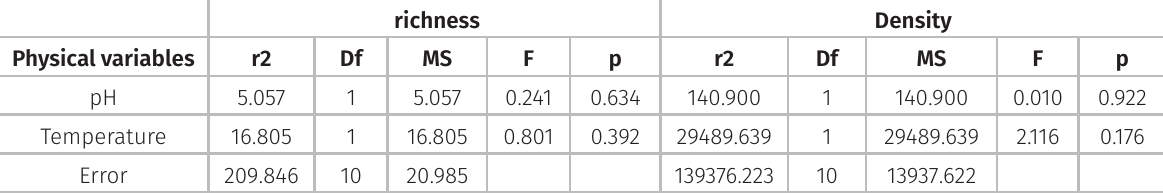
Table III. Summary results of a GLM - multiple regression analysis, testing the relationship between richness and mean density of freshwater turbellarians as a function of temperature and pH (physical